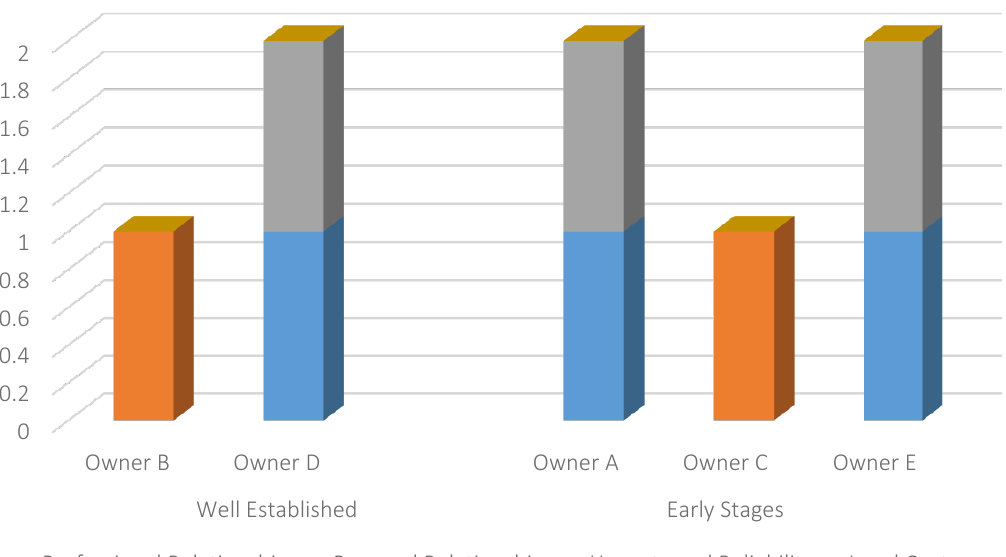
Figure 1. Relationship marketing to family